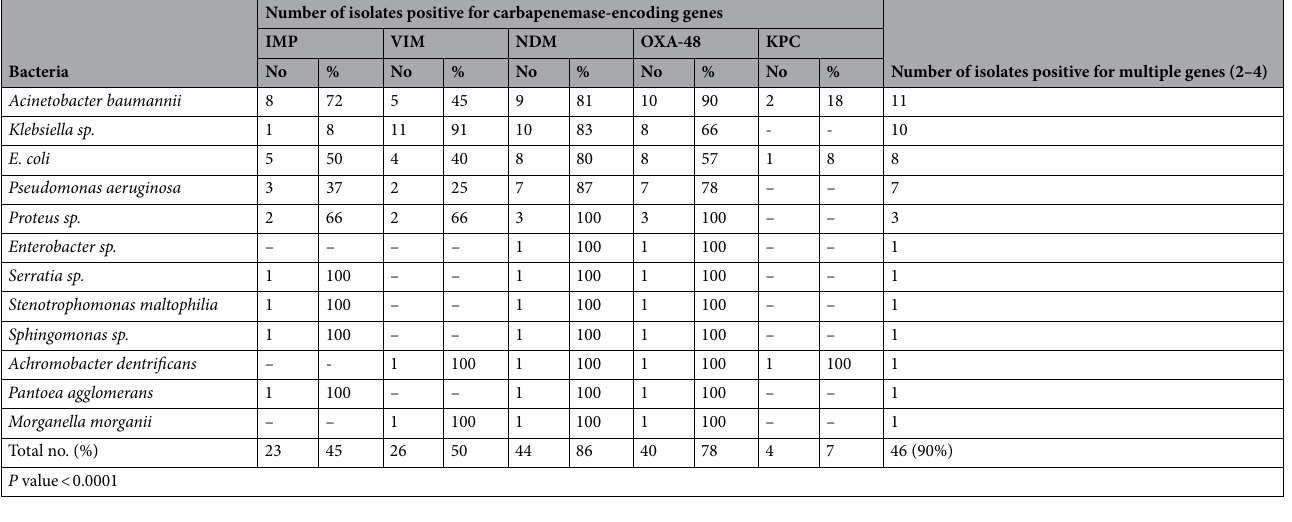
Table 3. Distribution of carbapenemase-encoding genes among CPGB (n =